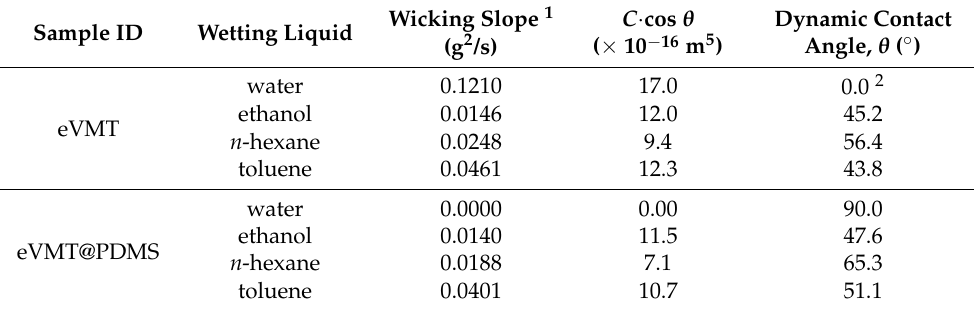
Table 1. Summarized results obtained from the capillary penetration experiments.